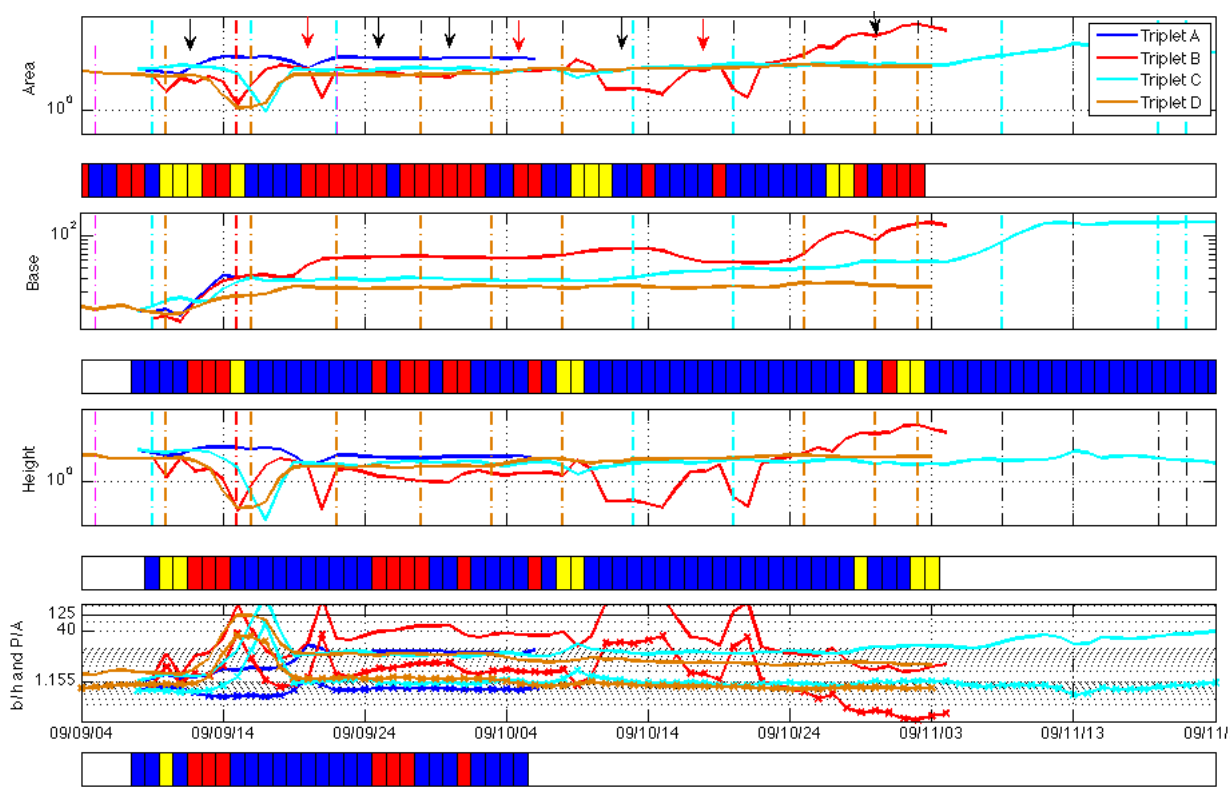
Figure 10. Triplet area evolution. Time series of triplet area, base, height, and base-to-height and perimeter-to-area ratios for triplets A to D. Solid lines in the lower panel depict the base-to-height ratio, while the lines with symbols depict the perimeter-to-area ratio. The value for the base-to-height ratio associated with an equilateral configuration (1.155) is also shown. Horizontal bar graphs depict on-, along-, and offshore ice drift as depicted in Fig. 6. Intervals excluded from DKP assessment based on the B/H threshold values found in Fig. 9 include 14–22 September 2009 for all triplets, 11–17 October 2009 and 19–22 October 2009 for triplet B, and following early November for triplet C. Triplet area evolution demonstrates enhanced variability in triplet B relative to triplets A, C, and D, with an increase in area near the ice edge in late October/early November. Higher base values are observed for triplets A and B relative to triplets C and D, in a manner consistent with local absolute dispersion (Fig. 4). The triplet base also provides a measure of two-particle dispersion and separation between a pair of particles/beacons/ice